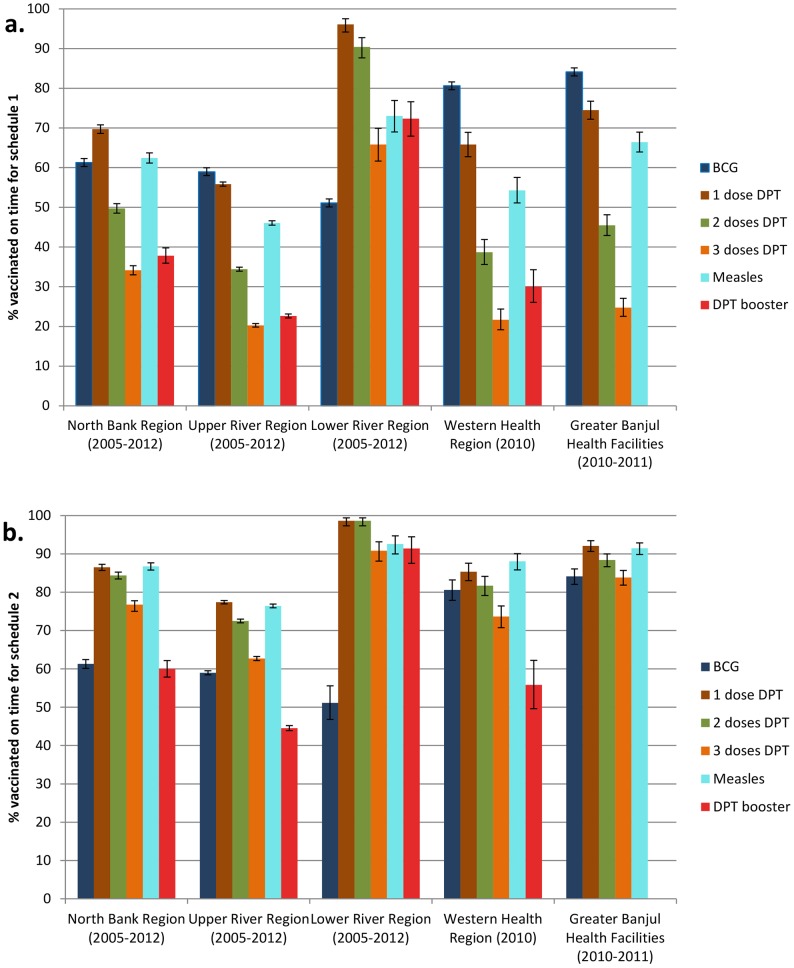
Estimated proportion vaccinated on time by age (months) by vaccine for each geographical region in the Gambia for a) schedule 1 and b) schedule 2.Blue bars: proportion who received BCG on time. Brown bars: proportion who received DPT1 on time. Green bars: proportion who received DPT2 on time. Orange bars: proportion who received DPT3 on time. Turquoise bars: proportion who received measles vaccine on time. Red bars: proportion who received DPT booster on time. Vertical bars: 95% confidence intervals.